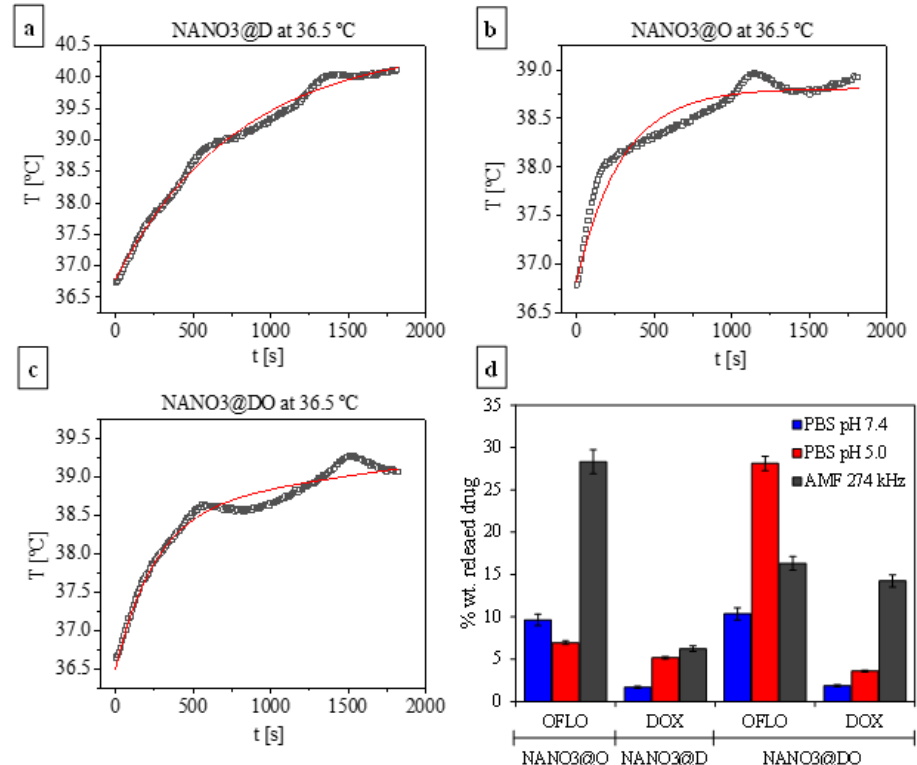
Figure 5. Hyperthermia heating profiles of NANO3@D ( a ), NANO3@O ( b ) and NANO3@DO ( c ), at 37 °C, under an AMF at 274 kHz and 2880 W, for 1800 s (30 min); black lines: experimental data, red lines: fitting of the experimental data. Maximum released drug from NANO3@D, NANO3@O and NANO3@DO, at 37 °C, under different conditions ( n = 3): blue = 0.01 M PBS pH 7.4, red = 0.01 M PBS pH 5.0 and grey = AMF at 274 kHz ( d ).